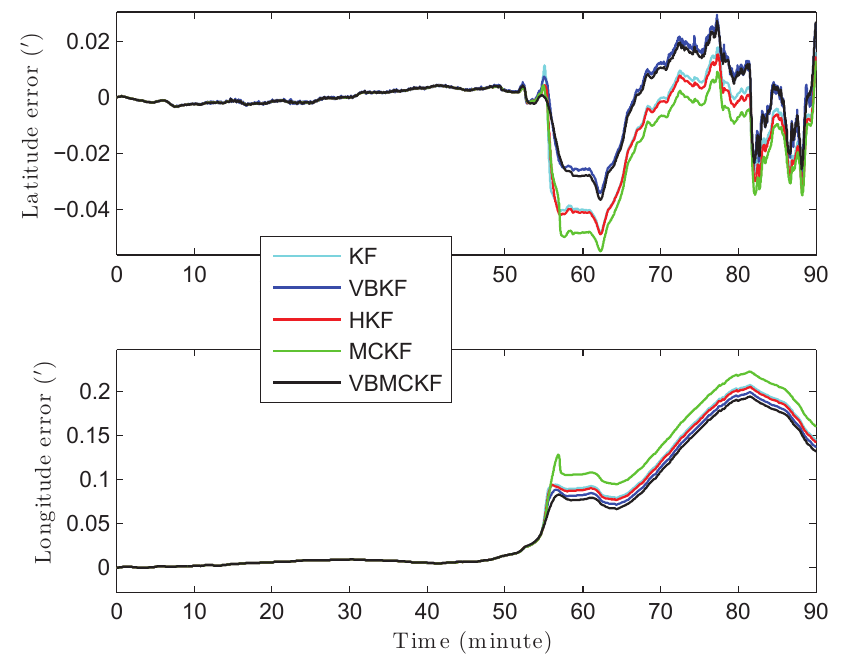
Figure 8. Position errors of different filters.